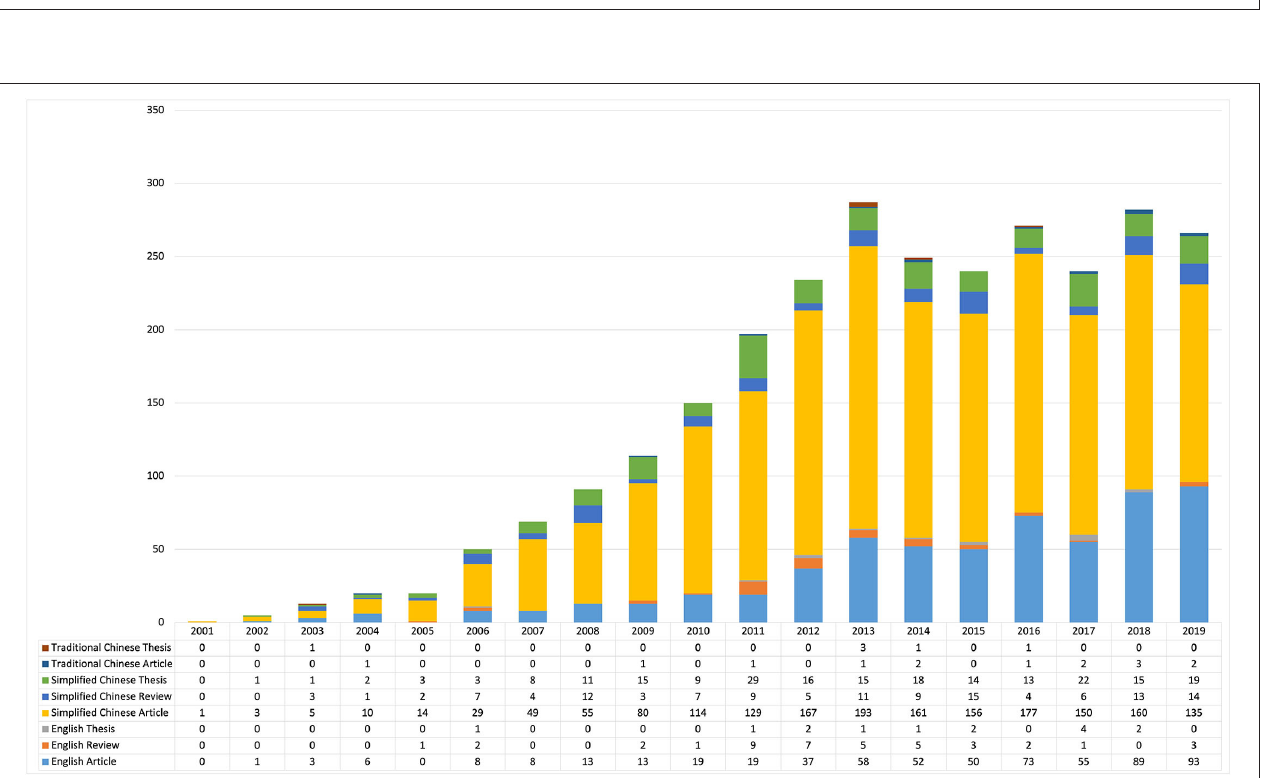
FIGURE 3 | Publication distribution by study types per year (2001–2019). Since this study only included references published before May 2020, the data in 2020 was dropped as it would be distracting the trends.